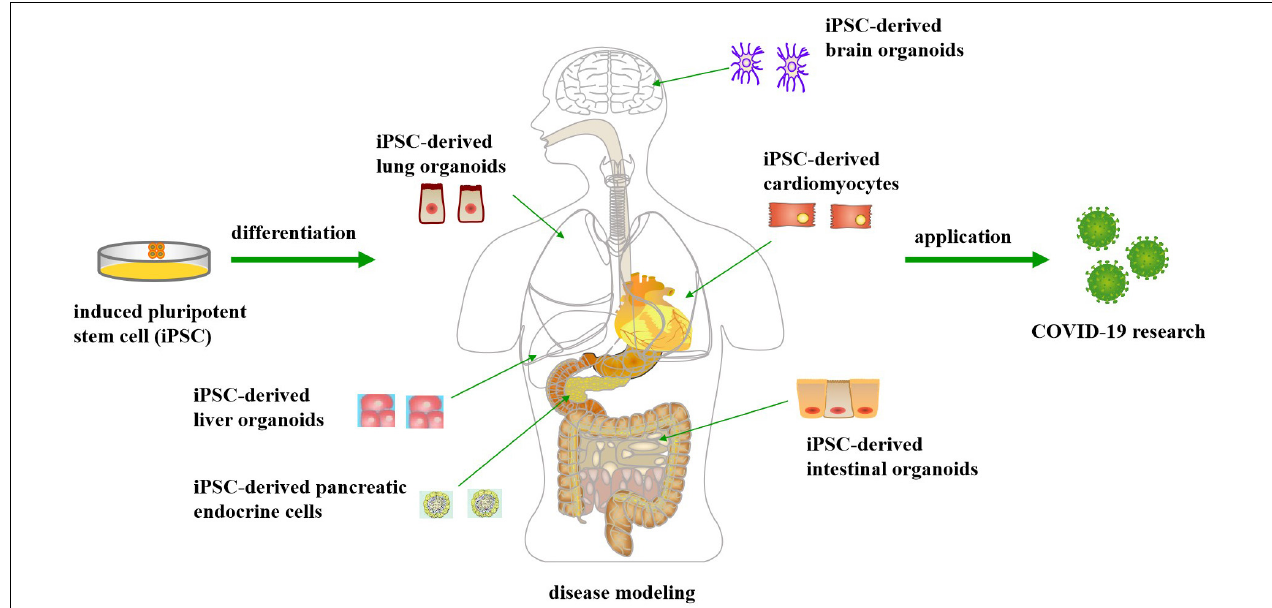
FIGURE 1 | Application of human induced pluripotent stem cell-derived cellular and organoid models for COVID-19